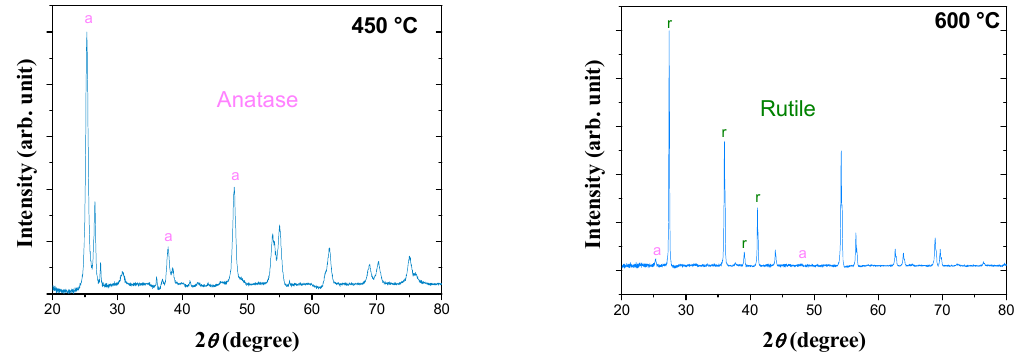
Figure 4. XRD patterns of the materials obtained after SPS cycles up to 450 and 600 °C under 400 MPa.